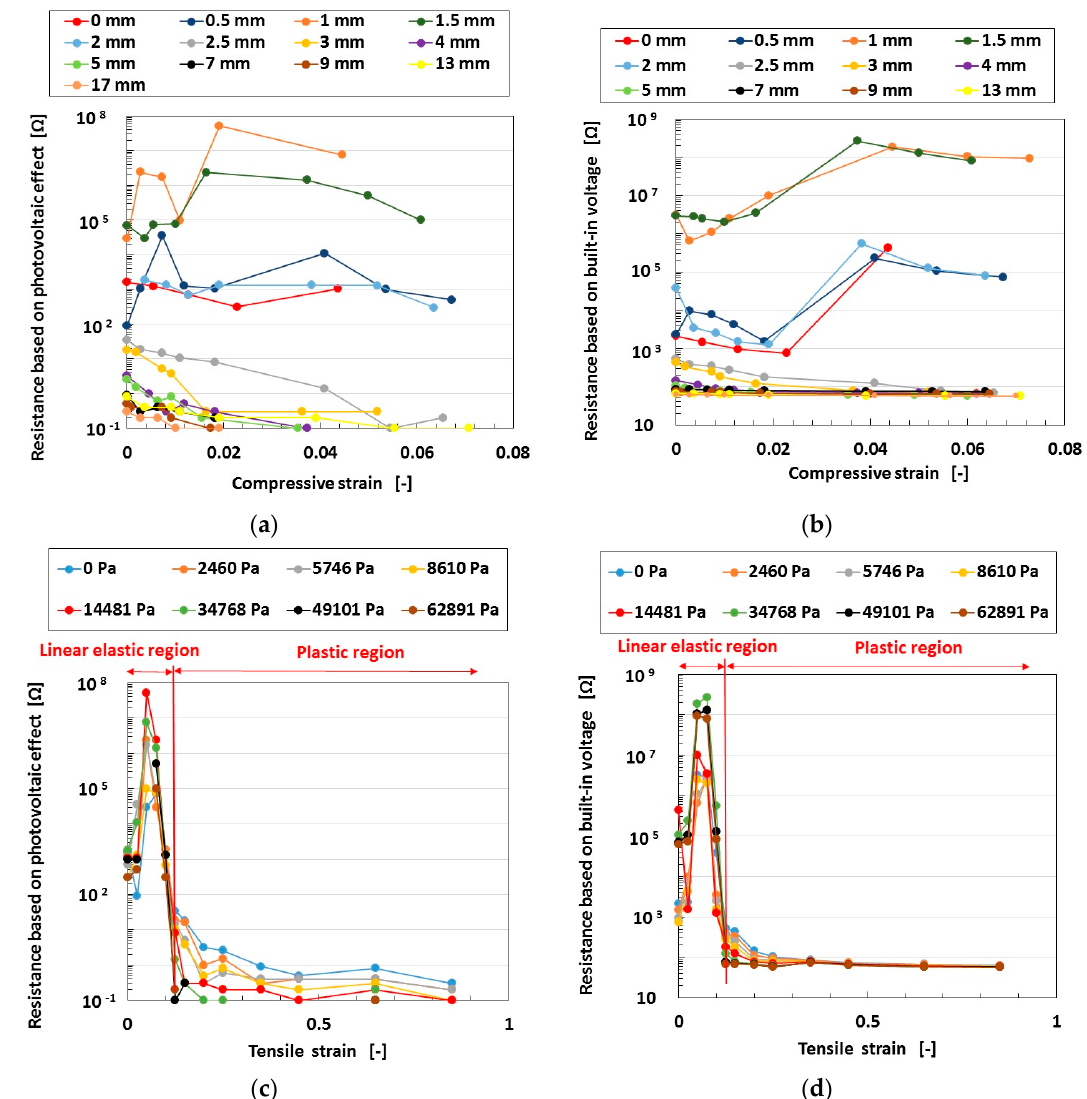
Figure 2. Changes in the effect of compression and elongation on resistance based on the photovoltaic effect and built-in electricity under ultraviolet light. ( a , b ) under compression; ( c , d ) under elongation; ( a , c ) based on photovoltaic effect; ( b , d ) based on built-in electricity for a wet-type MCF rubber solar cell electrolytically polymerized under a magnetic field with 0.22 g of Ruthenium complex dye and 7.4 g of KI+I 2 electrolyte. The MCF rubber had 3 g of TiO 2 , 6 g of Ni, 4.5 g of MF, and 9 g of natural rubber (NR)-latex. The irradiation light was ultraviolet (40 lx).